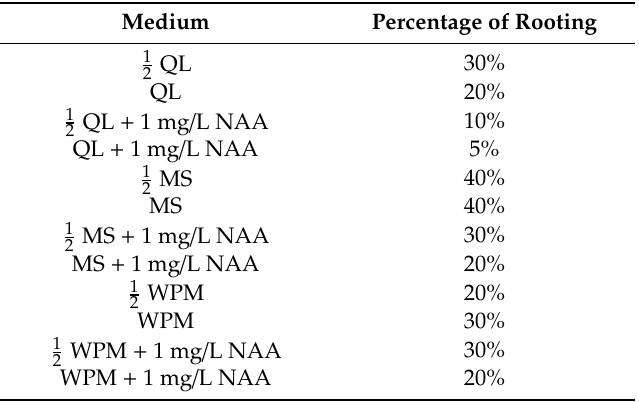
Table 5. The percentage of rooting of Hyssopus angustifolius in di ff erent media.